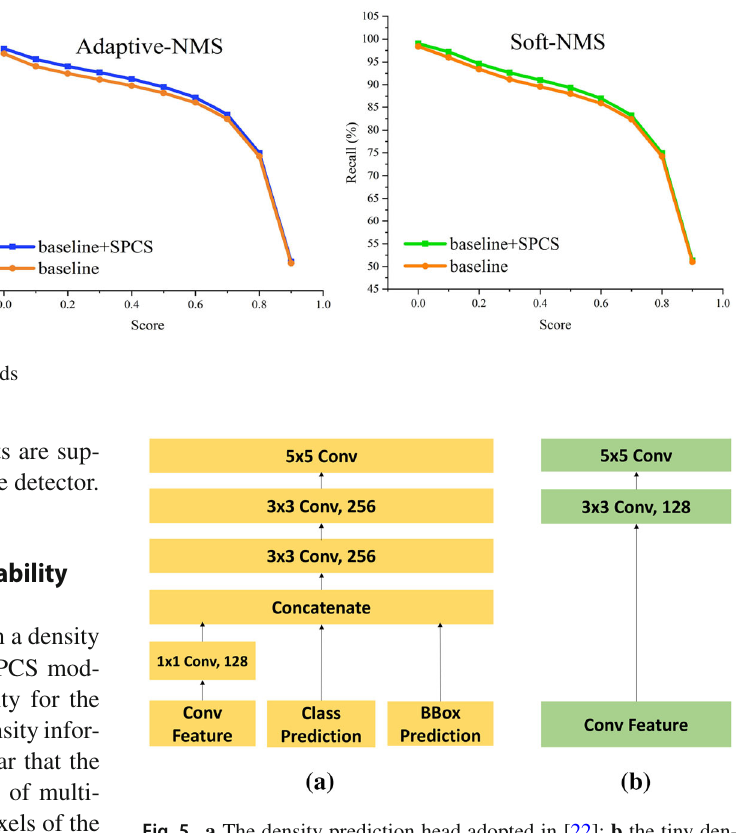
Fig. 5 a The density prediction head adopted in [22]; b the tiny den- sity prediction head we adopted in our model. To make the information extraction ability of SPCS module prominent, we use a simple structure for density prediction to prevent that other extra complex structure will cover up the shortage in information extraction ability of the original model. Except the end convolutional layers which output the